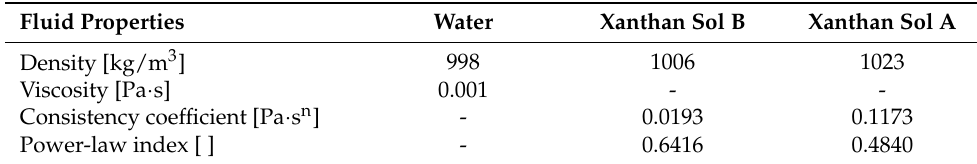
Table 1. Characterization of the mimicking fluids used in the abiotic